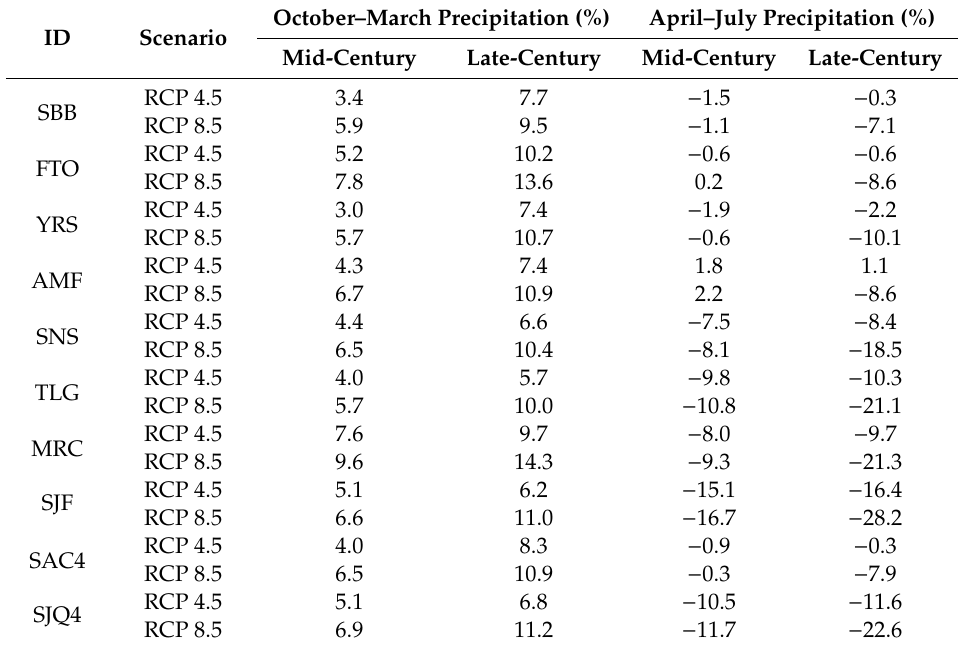
Table 5. Percent di ff erence of mean projection on October–March and April–July precipitation from the historical